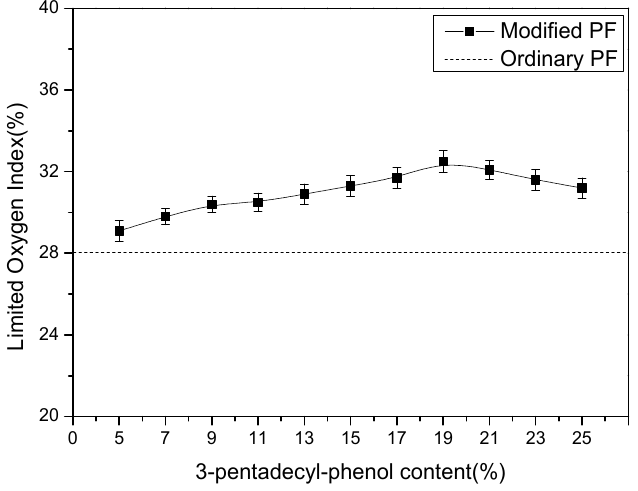
Figure 12. The effect of 3-pentadecyl-phenol with different contents on the limited oxygen index of the foam.